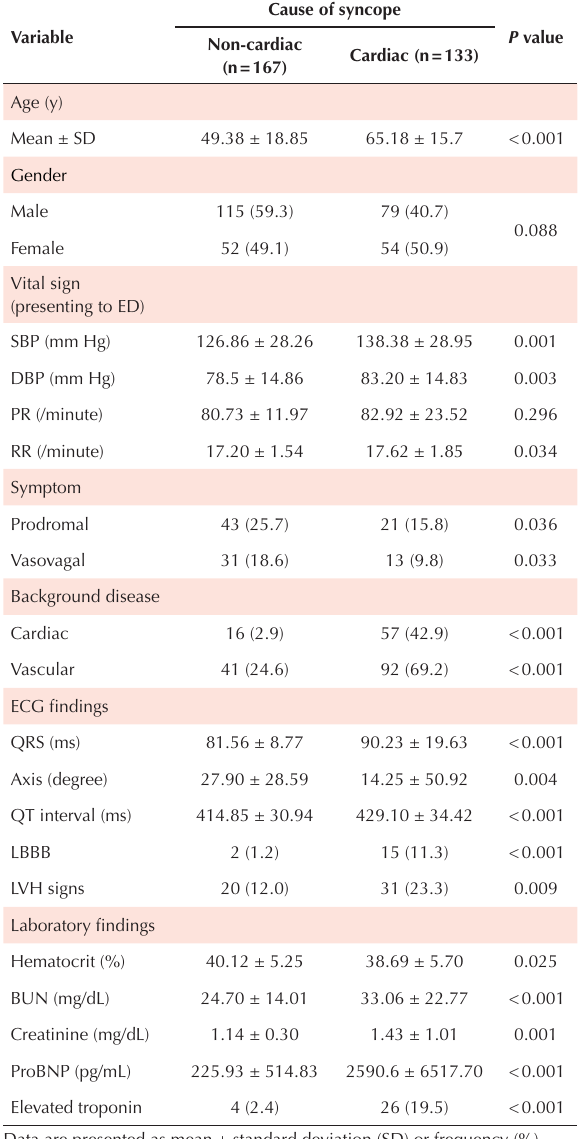
Cause of syncope